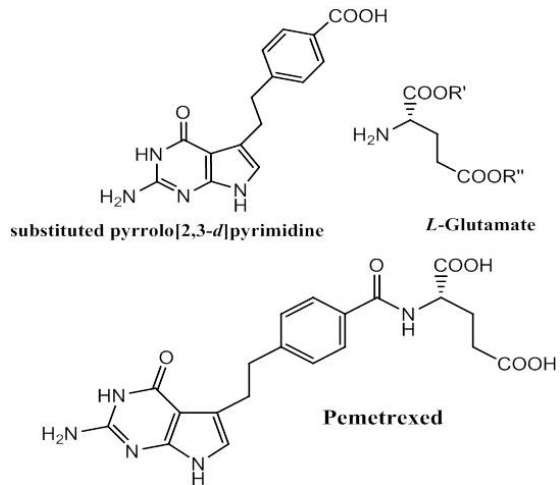
Figure 4. Pemetrexed synthetic pathway: 2,6-diamino-4(3 H )-pyrimidinone as starting material to obtain substituted pyrrolo [2,3- d ] pyrimidine, which reacts in a conventional peptide coupling with